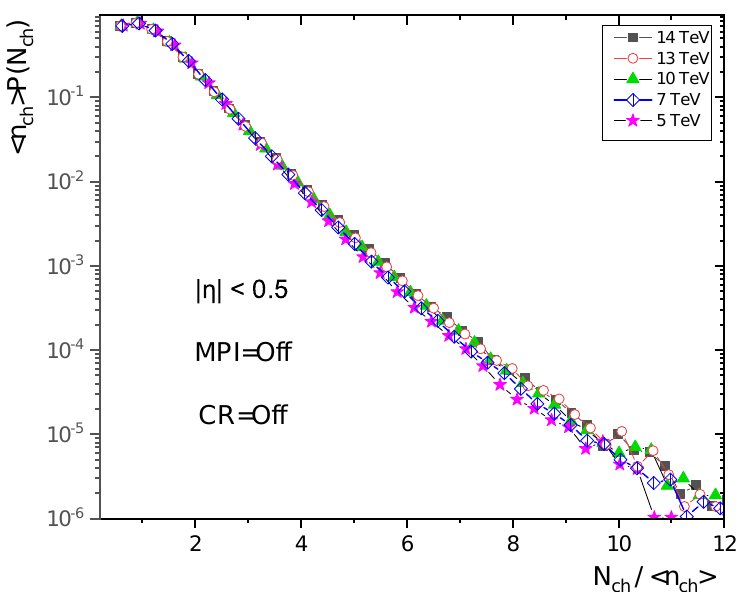
Figure 12. KNO form of charged particle multiplicity distribution at different energies in pseudora- pidity | η | < 0.5 with MPI = OFF and CR = OFF.